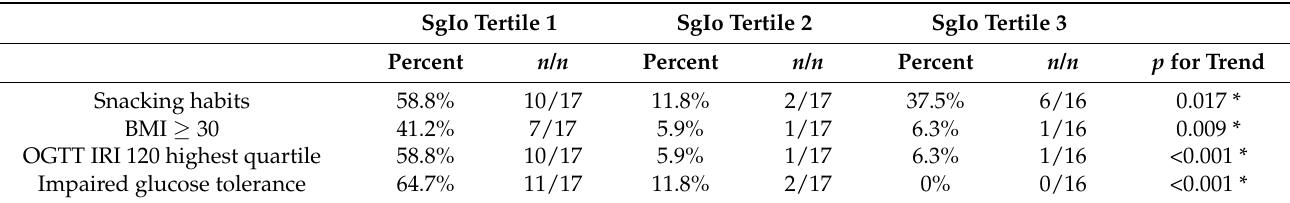
Table 6. The proportions of the participants with snacking habits, obesity, hyperinsulinemia, and dysglycemia, according to SgIo tertile category.